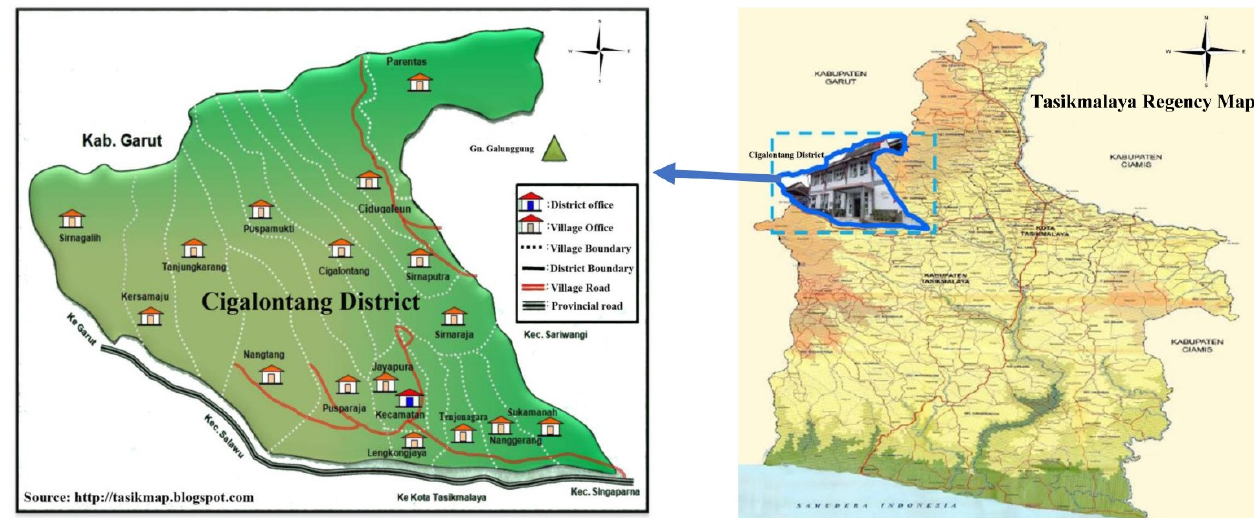
Figure 2. Regional layout in the map of Cigalontang District, Tasikmalaya Regency.